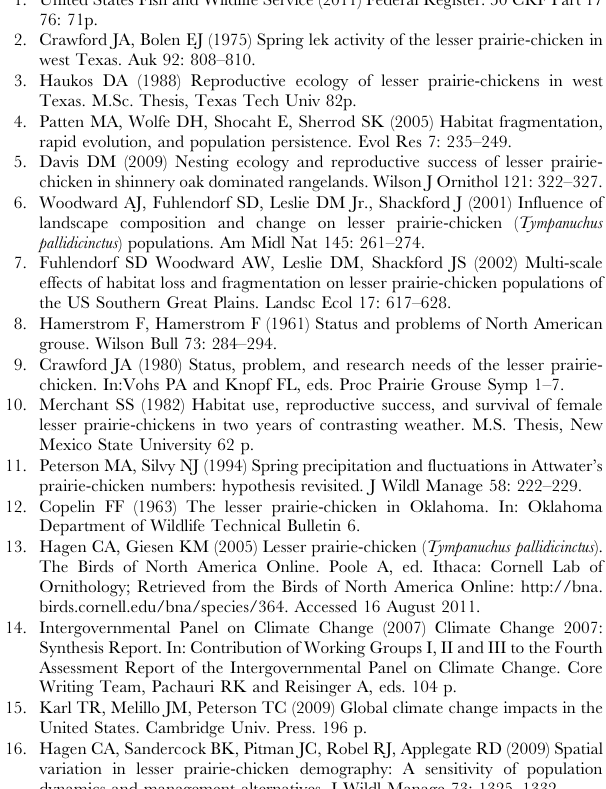
Table S1 Values, means, and standard errors for weather data collected on site. Values, means, and associated